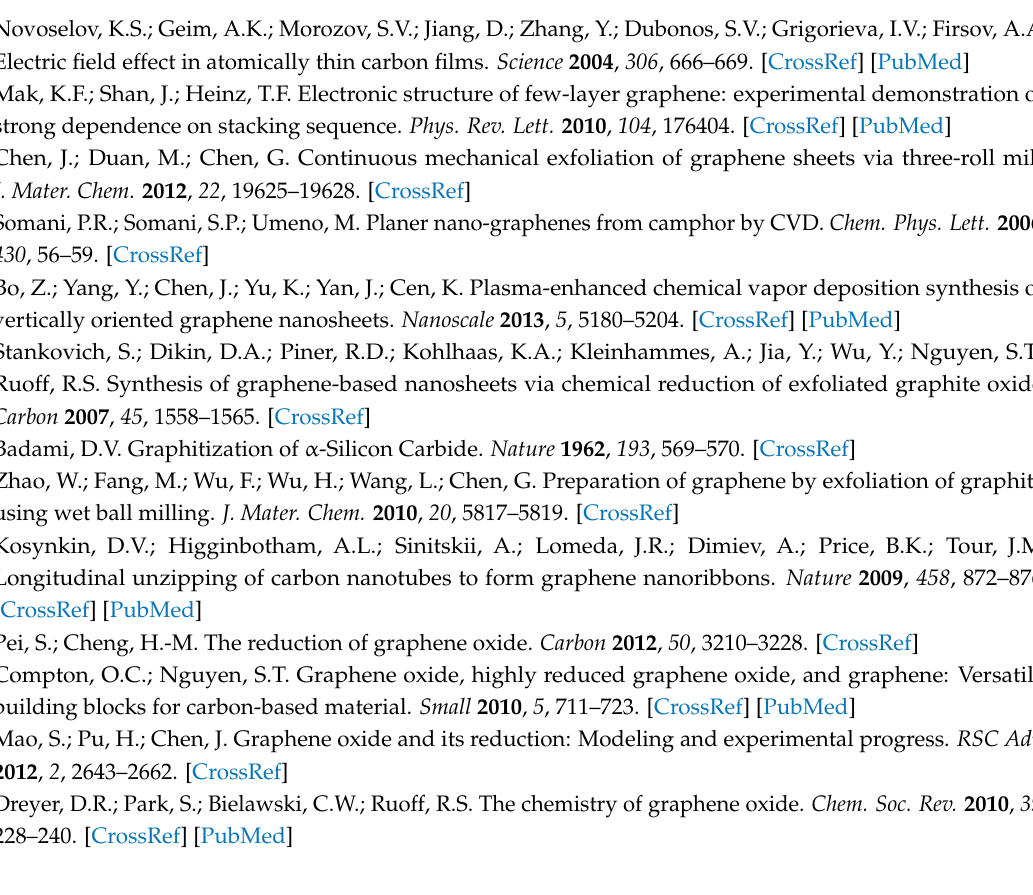
Figure S5: Representative AFM image of the noticeable interface differences between the laser-scribed GO region and unscribed GO region; Green line shows relative height profile (up to ~1.5 µ m) to the left and right area, bounding the white dotted